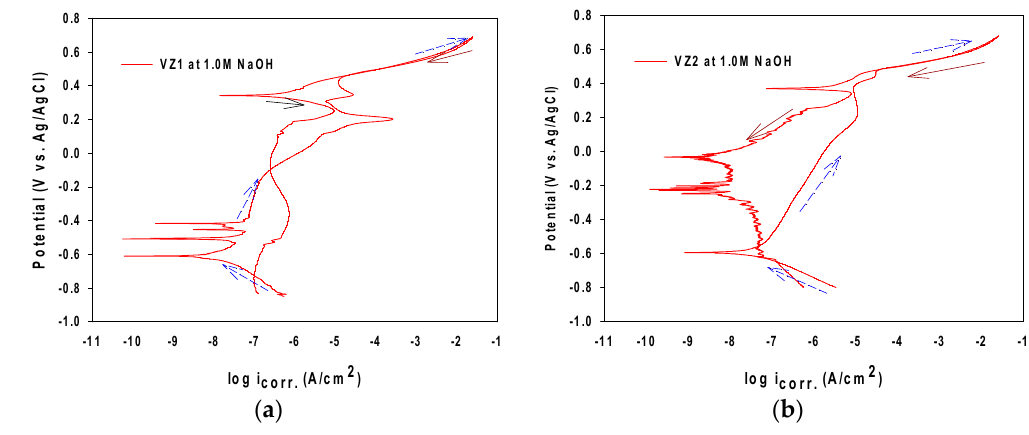
Figure 4. Cyclic polarization curves of Ni-base glassy alloys at 1.0 M NaOH at 27 °C (Arrows with short dash and blue color is upwards and arrows with solid line and dark red color is downwards): ( a ) VZ1 alloy and ( b ) VZ2 alloy.